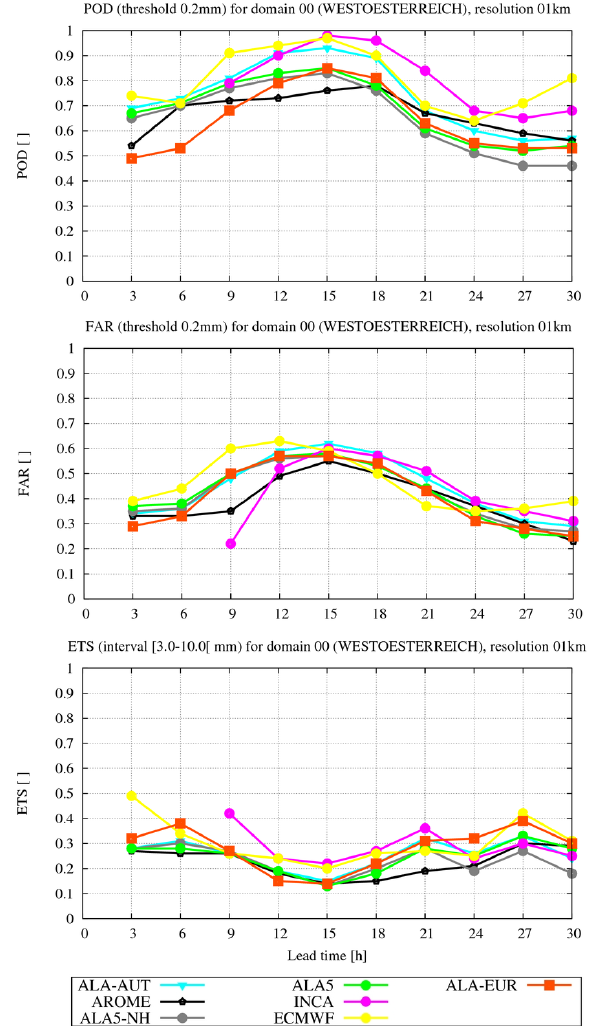
Figure 6. FAR, POD and ETS for di ff erent models (verification period